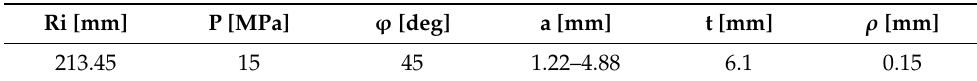
Figure 2. Details of the geometry and notch study, with boundary conditions. Table 1. Geometry properties and load.